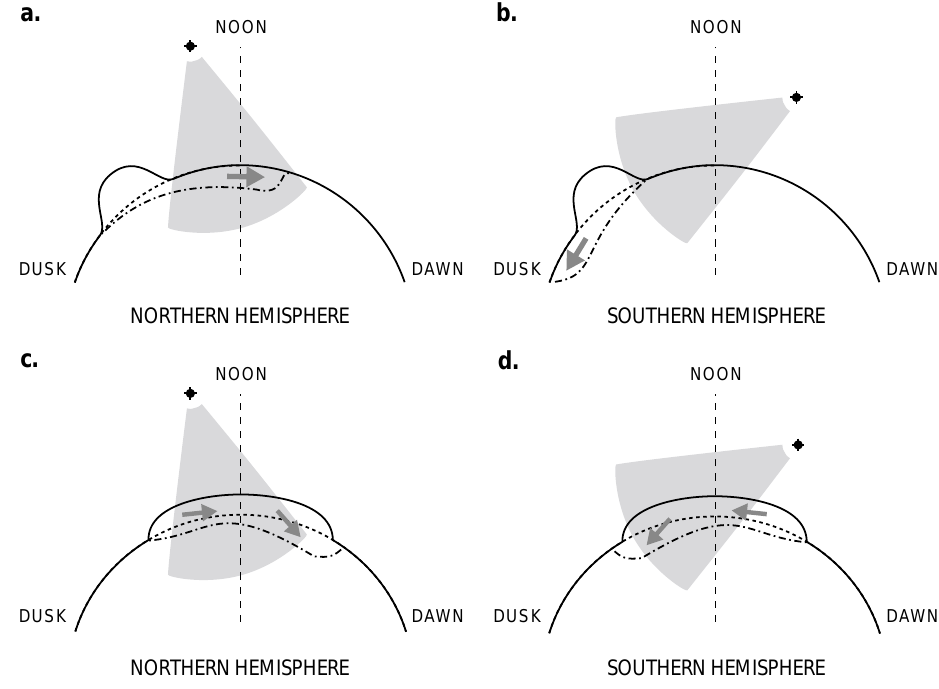
Fig. 8. Schematic indicating the expected perturbations to the ionospheric open-closed field line boundary (OCFLB) and the resulting ionospheric flows due to the addition of open flux during a flux transfer event. In each figure, the view is from a location above the northern magnetic pole, with the noon meridian indicated by a long dashed line and dawn (dusk) located to the right (left) of the plot. In each case the OCFLB is represented by a solid black line. The field-of-view of the Finland (Syowa East) radar is indicated in the Northern (Southern) Hemisphere by the grey shaded region at approximately 10:00 UT. Where a perturbation (i.e. a region of newly-opened flux tubes appended to the OCFLB) is shown, the quasi-equilibrium position of the boundary is indicated by a short dashed line. Following integration into the (open) polar cap, the region of newly-opened flux is indicated by a dot-dashed line whilst the ionospheric flow that brings about the inclusion of this region into the polar cap is indicated by a shaded arrow. The expected Northern and Southern Hemisphere responses to the addition of open flux in the post-noon sector are shown in (a) and (b) respectively. Similarly, the expected Northern and Southern Hemisphere responses to the addition of a spatially extended region open flux that straddles noon are shown in (c) and (d)